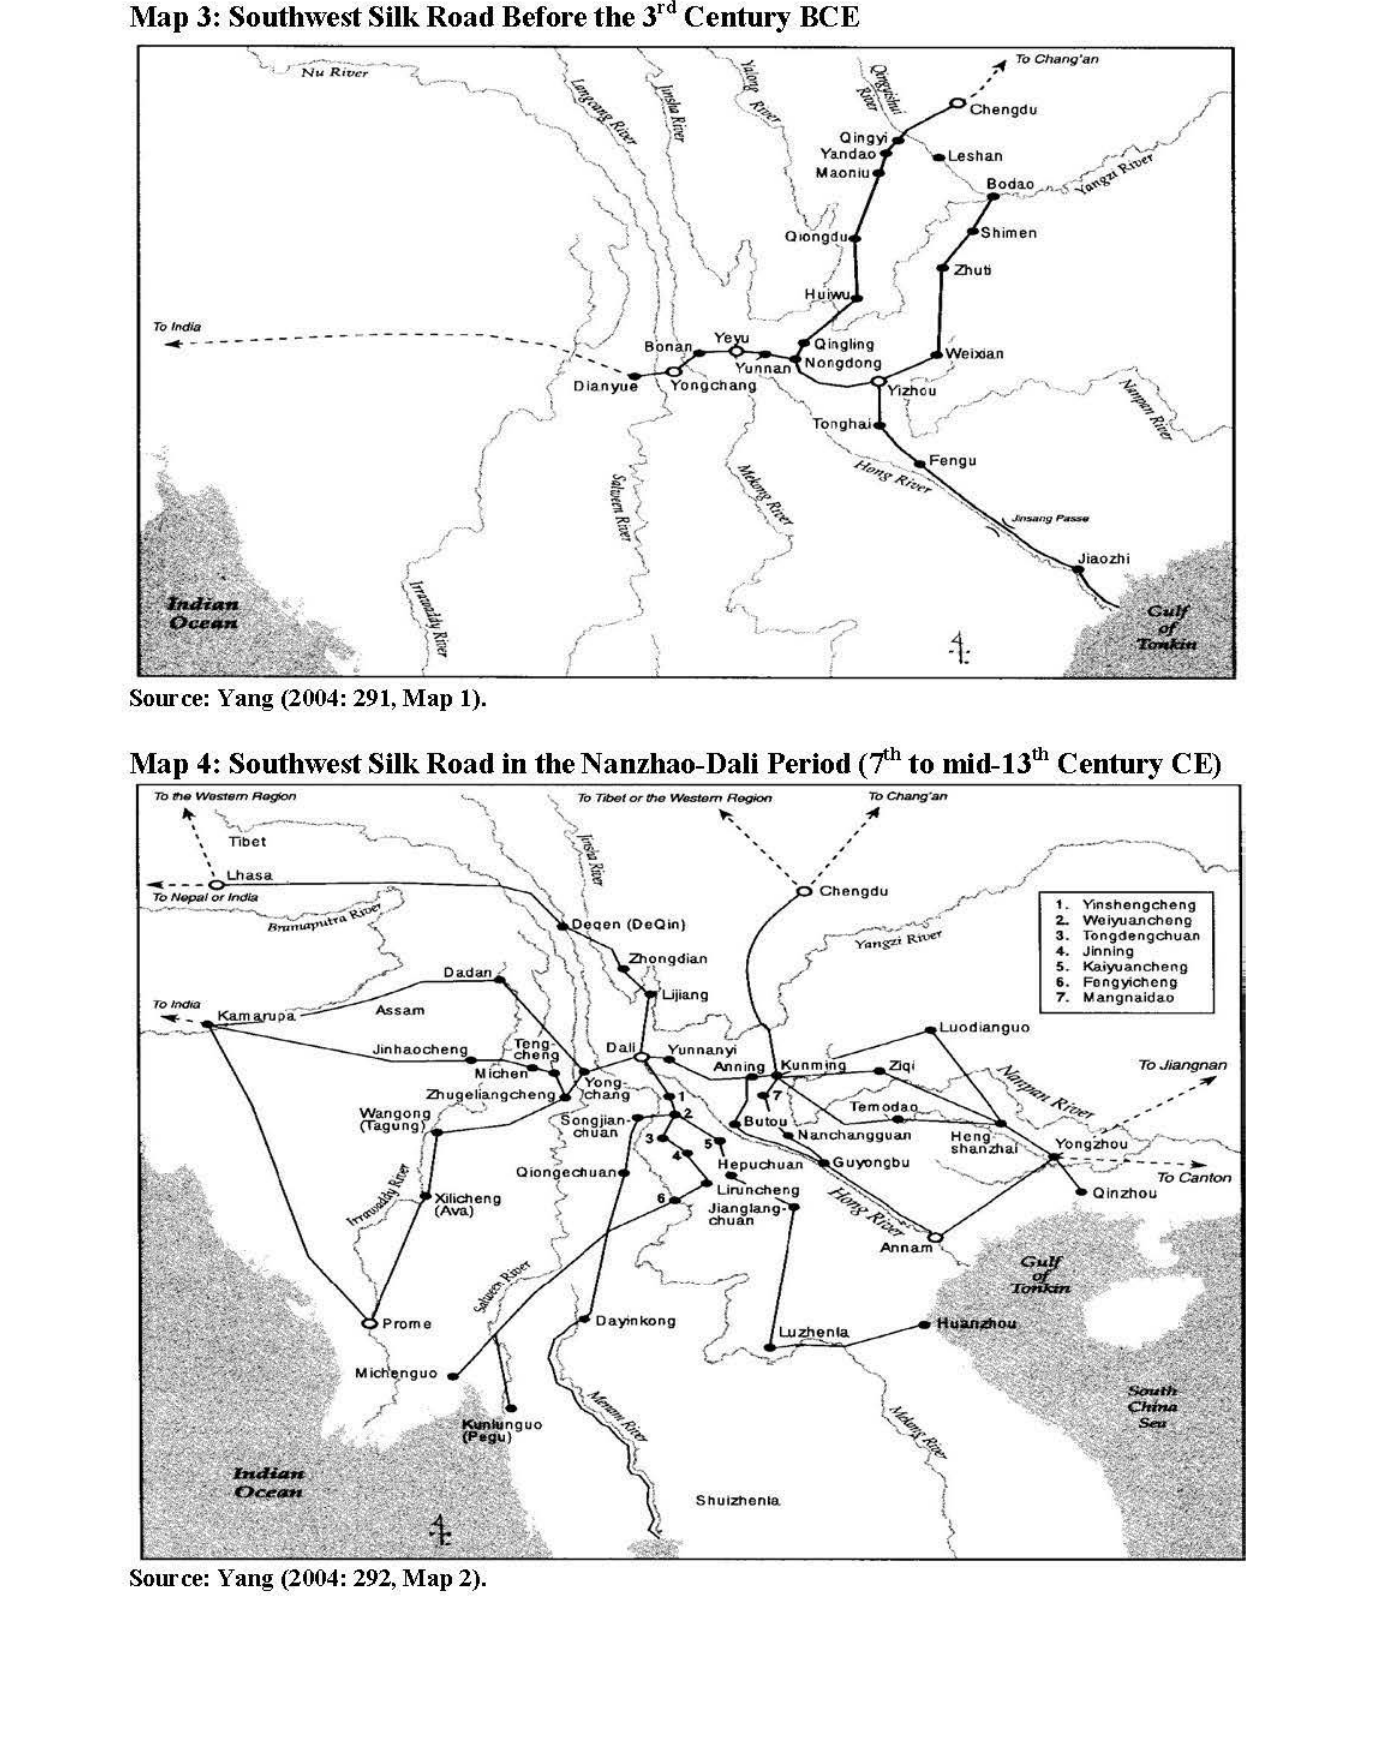
Somce: Yang (2004: 291, Map 1). Map 4: Southwest Silk Road in the Nanzhao-Dali Period (7°1 to mid-13th Century